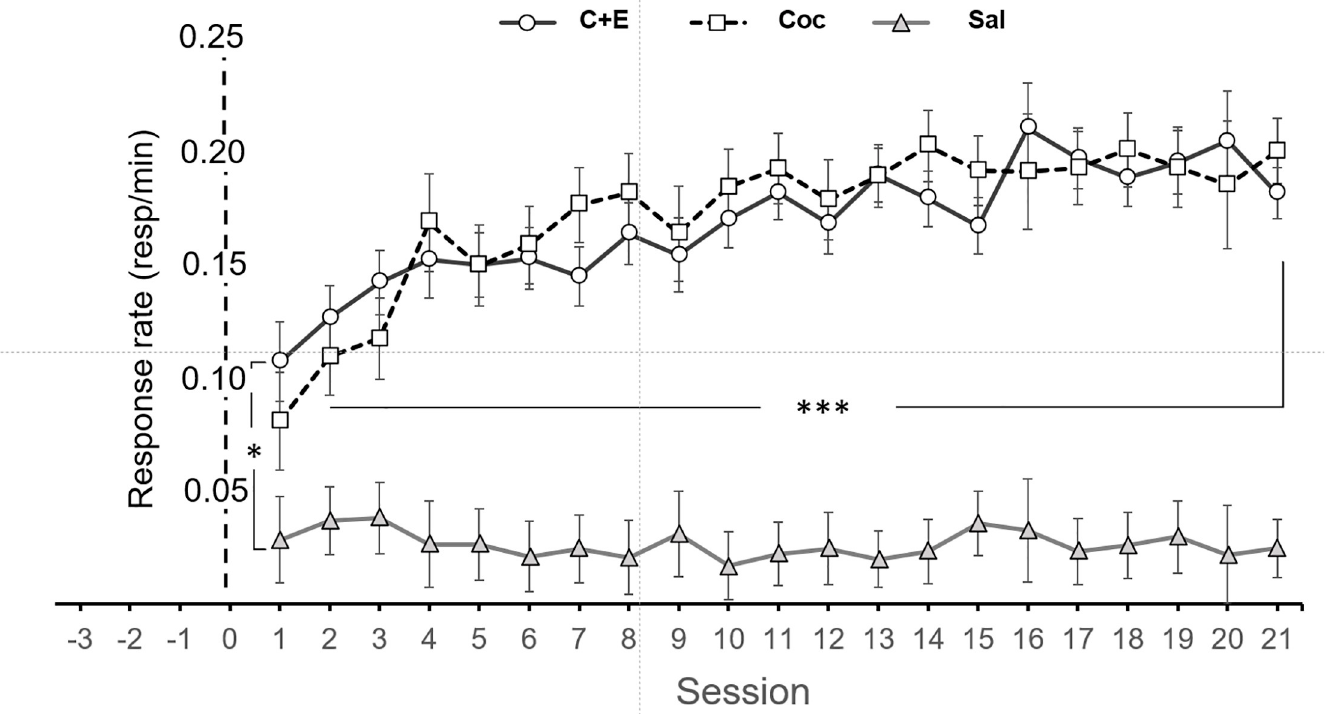
Fig 3. Maintenance of Coc and C+E self-administration. Mean ( ± SEM) of the response rate/time (lever presses per minute). The C+E and Coc rats follow a similar pattern of escalation. No session-sex interaction was detected.